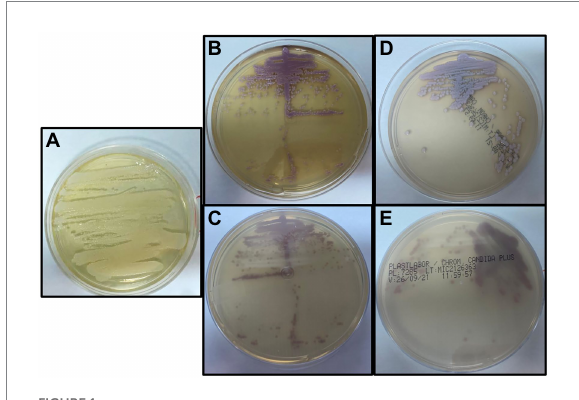
FIGURE 1 (A) Growth on Sabouraud Dextrose Agar after incubation at 30 ° C for 48 h in aerobic conditions. (B,C) Growth on CHROMagar ™ Candida after incubation at 35 ° C for 48 h in aerobic conditions. (D,E) Growth on CHROMagar Candida Plus after incubation at 35 ° C for 48 h in aerobic conditions.